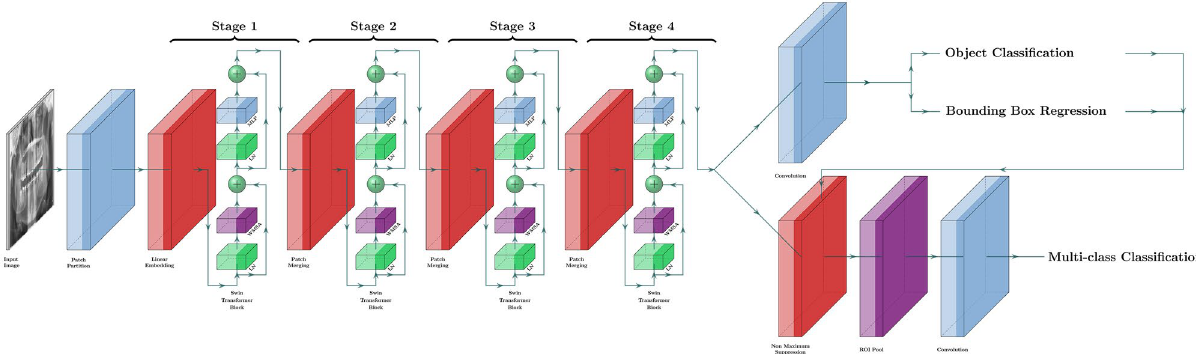
Figure 1. Faster R-CNN with